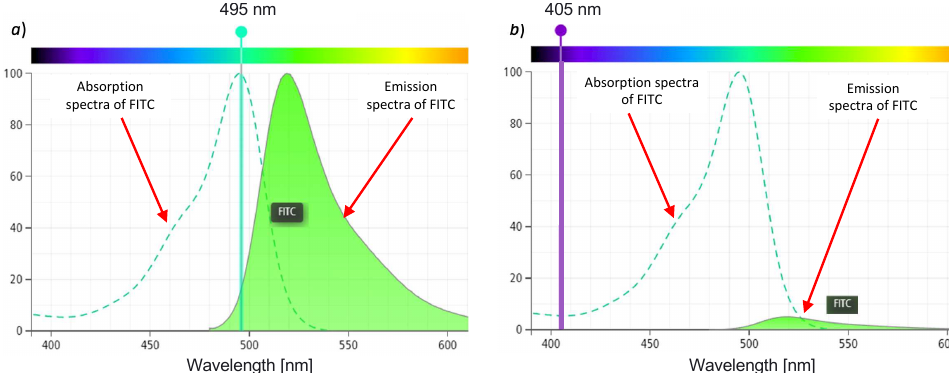
Figure 6. Absorbance and emission spectra of FITC fluorophore. ( a ) Excitation at 495nm and ( b ) excitation at